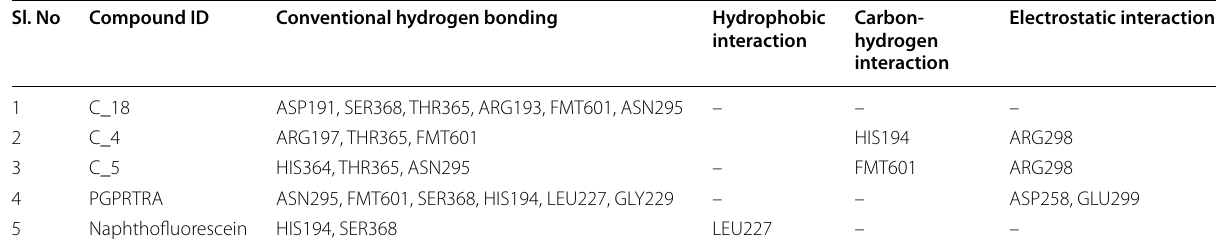
Table 6 Binding parameters of the phytocompounds and the standard references with the amino acid residues at the active binding site of furin Sl. No